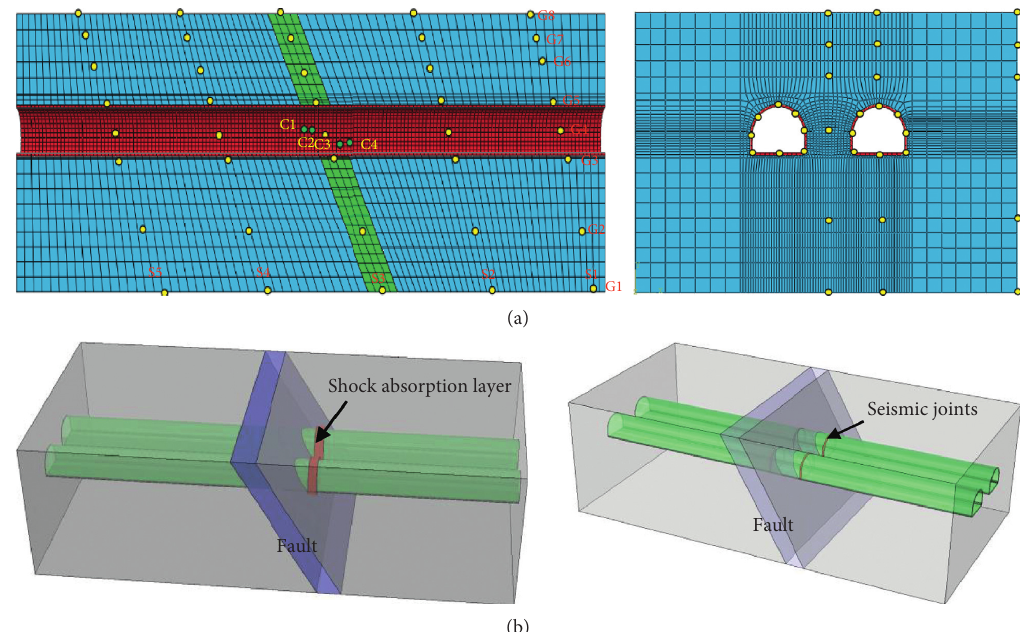
Figure 7: Monitoring points and setting of seismic measures in the numerical model. (a) Monitoring points. (b) Seismic